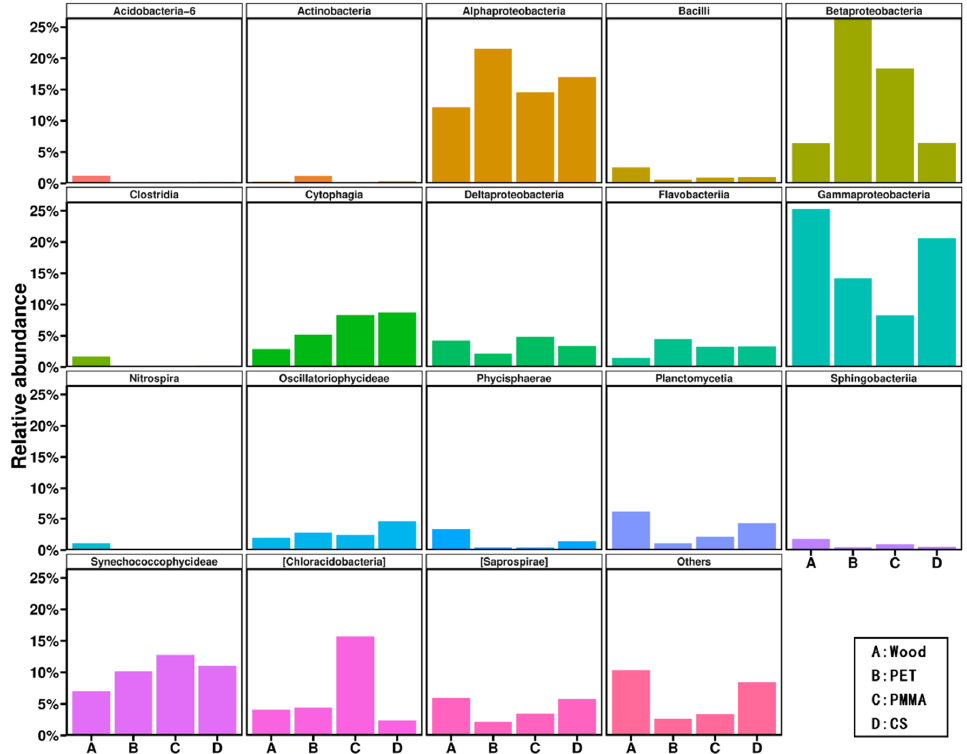
Figure 5. Relative abundance of bacteria at the class level. The figure shows bacteria in A (Wood), B (PET), C (PMMA), and D (CS) substrates with relative abundance greater than 0.01.